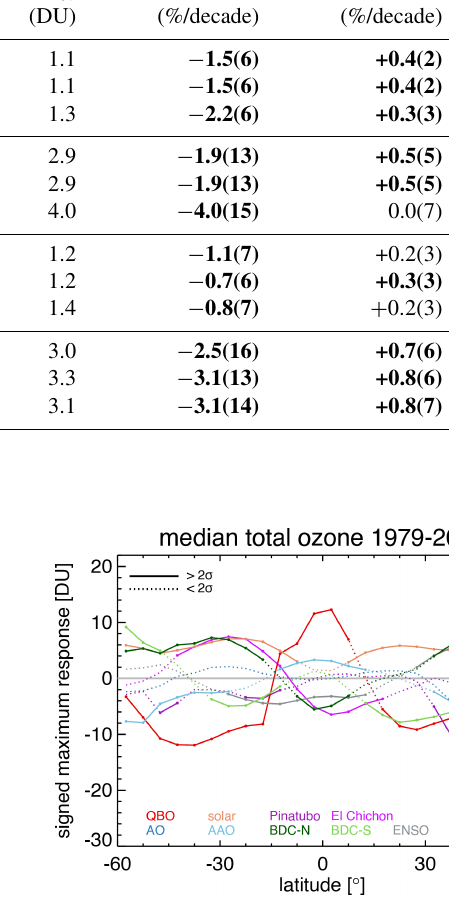
Table 4. Different MLR settings applied to the broad zonal mean median ozone time series. For explanations of terms, see Table 3. Standard MLR is based upon Eq. (1) with P ( t ) = 0. Iterative MLR means that only terms of P ( t ) and El Niño term are fitted when they are statistically significant (2 σ ), while full MLR includes all terms in Eq. (1) and P ( t ). Zonal bands MLR Parameters r 2